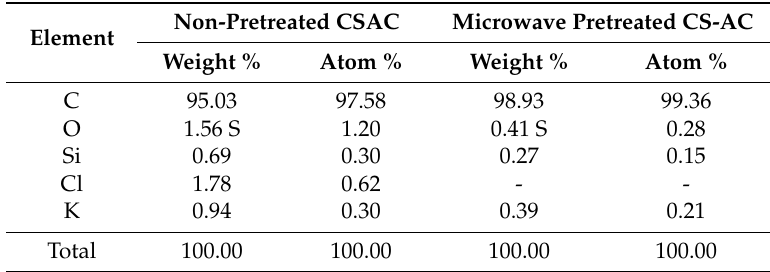
Table 2. Elemental composition of microwave pretreated and non-pretreated CSAC as determined by the EDX. Non-Pretreated CSAC Microwave Pretreated CS-AC Element Weight % Atom % Weight % Atom %